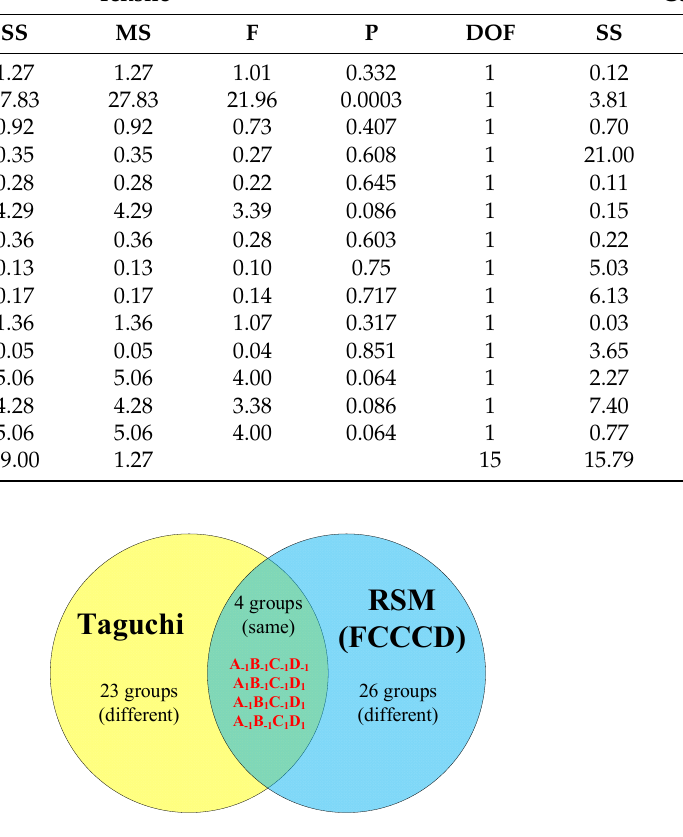
Figure 7. Relationship of experimental groups of Taguchi and